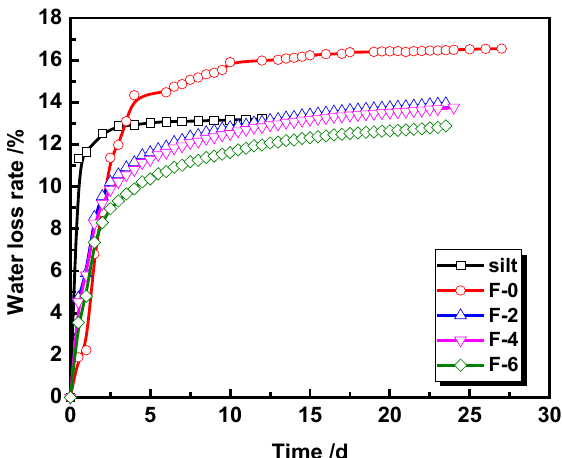
Figure 6. Variation of water loss rate with time.